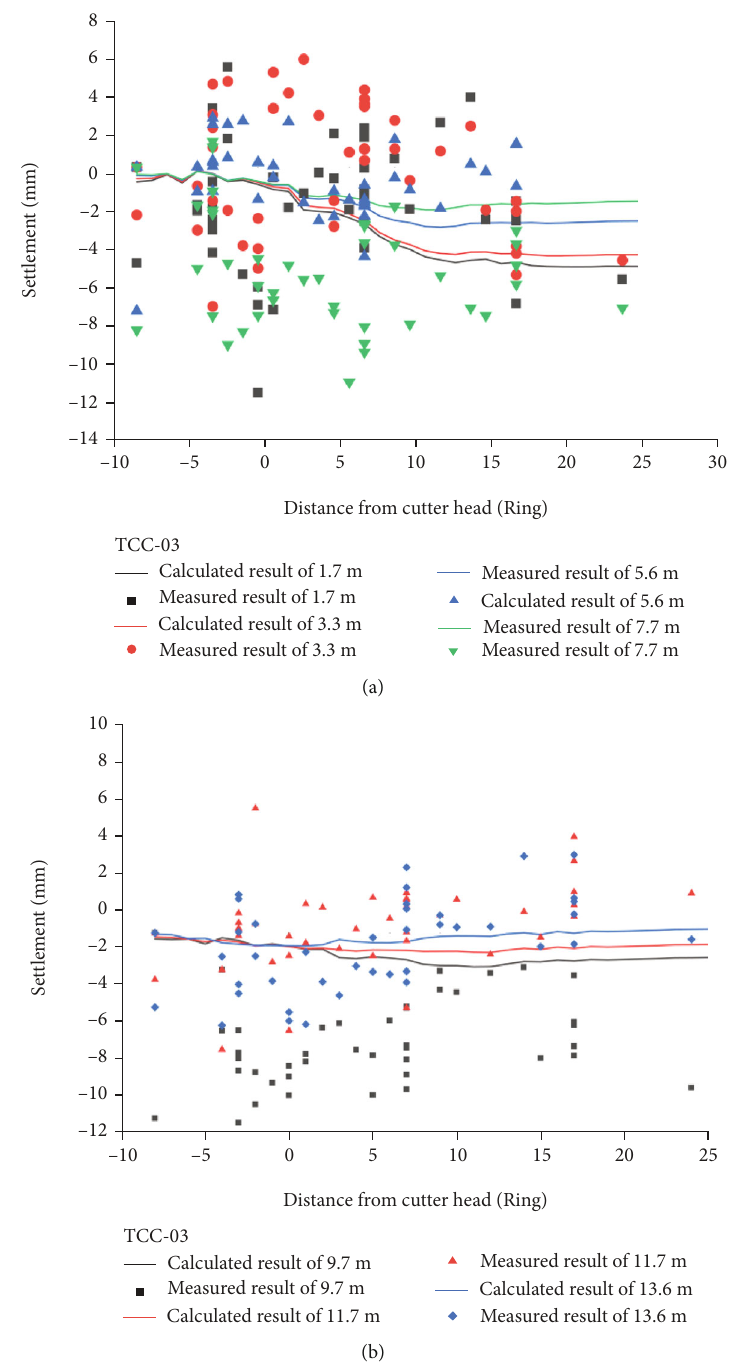
Figure 8: Comparison of time history curve of layered settlement at the center of two tunnels: (a) TCC-03 and (b)